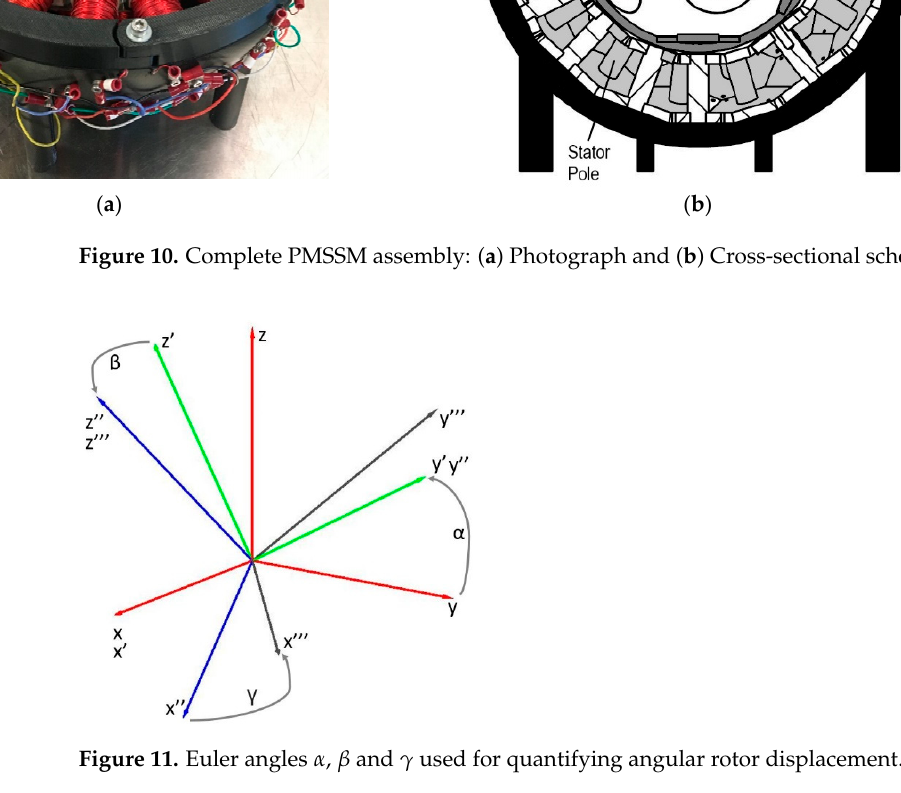
Figure 11. Euler angles α , β and γ used for quantifying angular rotor displacement.